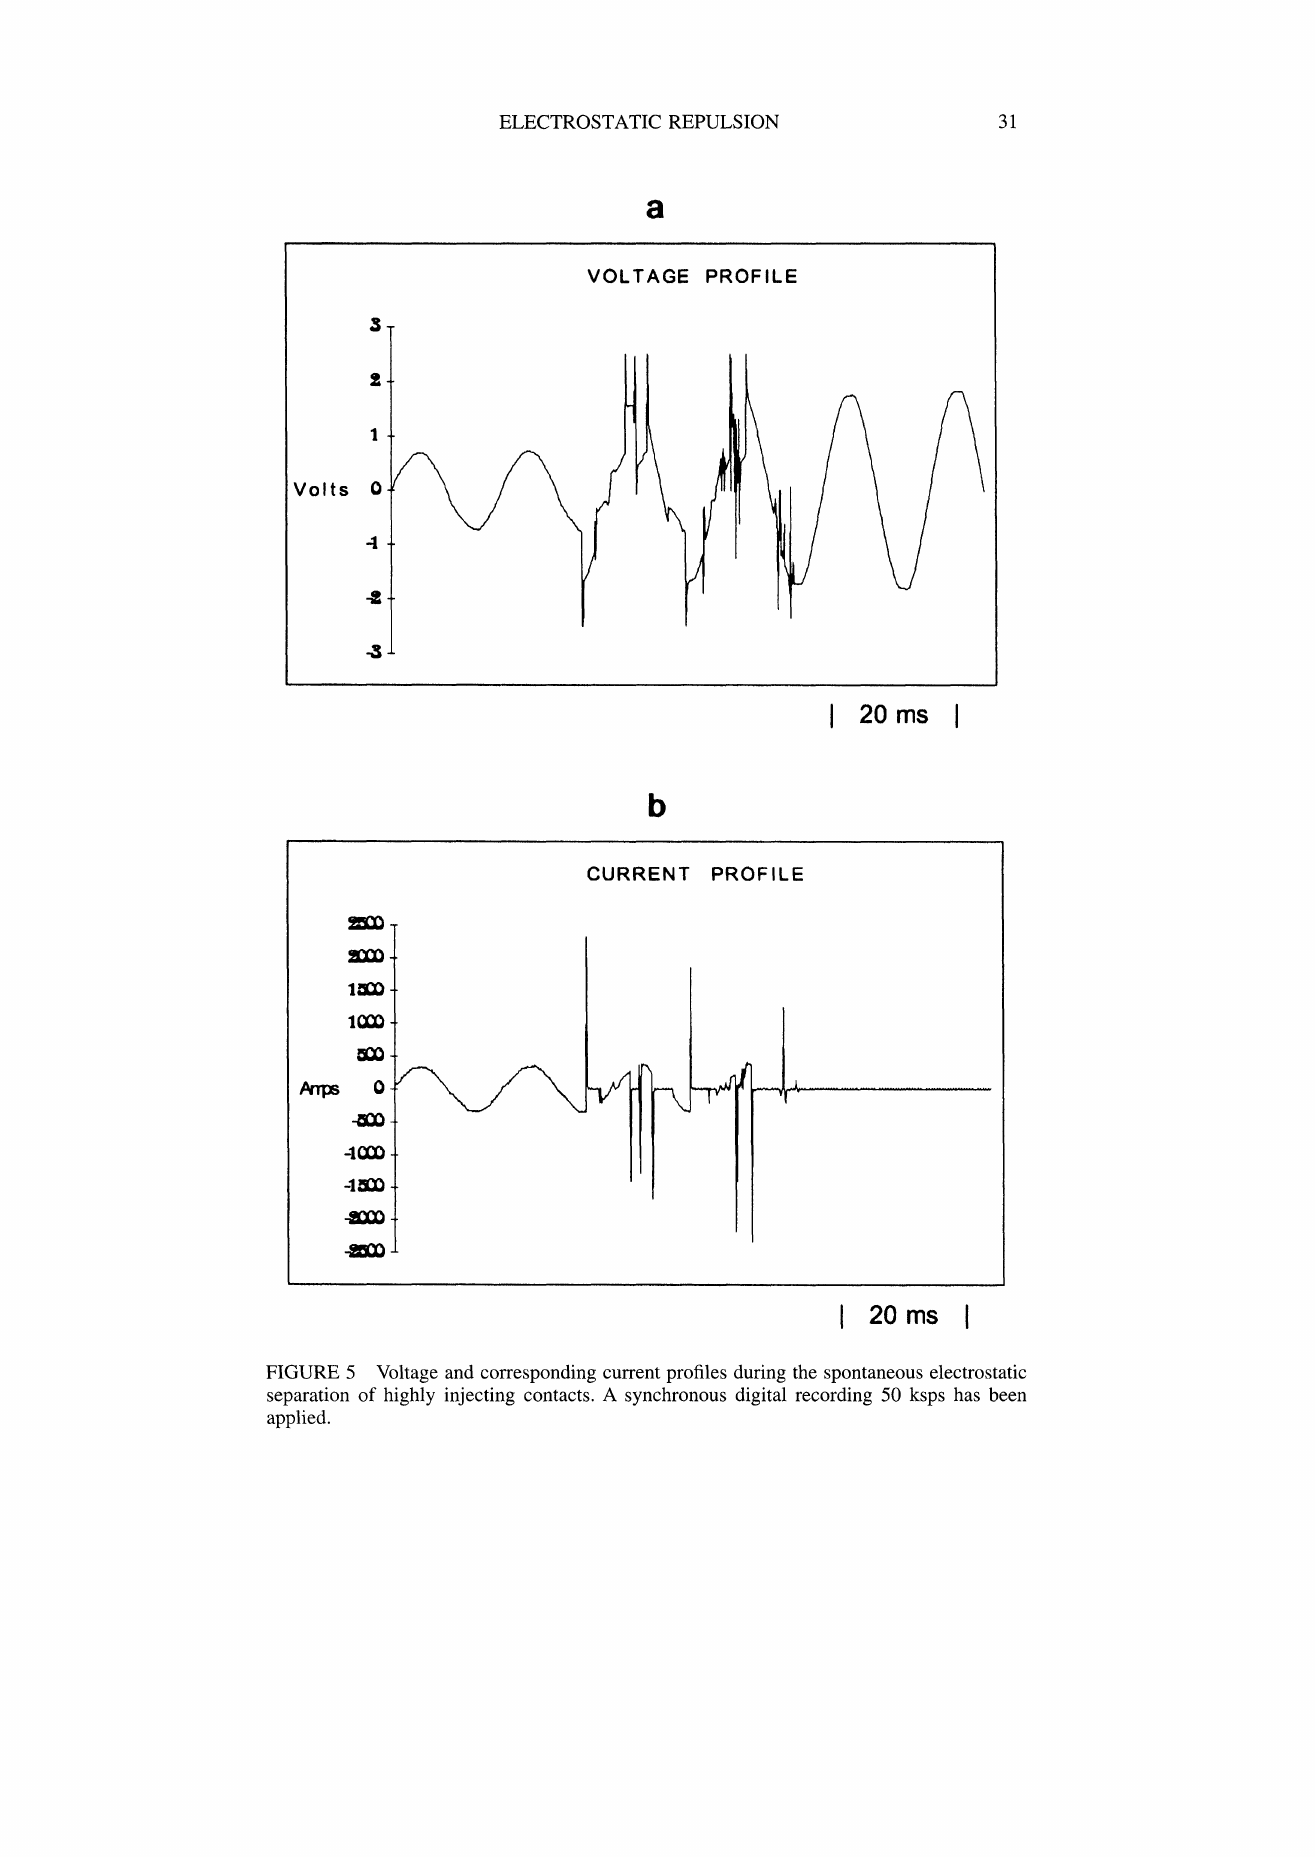
FIGURE 5 Voltage and corresponding current profiles during the spontaneous electrostatic separation of highly injecting contacts. A synchronous digital recording 50 ksps has been